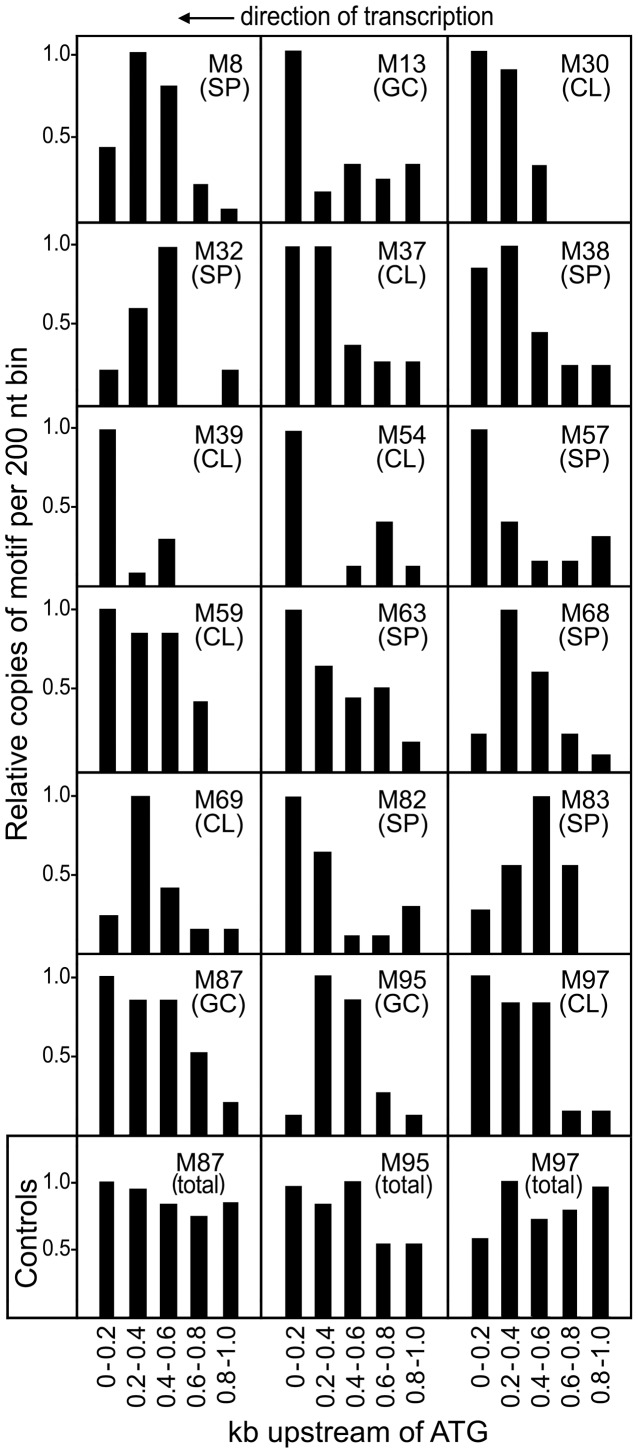
Positional bias of representative motifs within promoter space.The relative frequency of each motif is mapped across 200-nt bins taken from the relevant stage-induced promoter set, normalized to a value of 1.0 for the most populous bin. Marked in each panel is the motif and promoter dataset used for analysis, using the abbreviations in Figure 4. The bottom row shows three controls, indicating the frequency of three motifs in 2000 randomly selected promoters. The actual number of hits for each motif in the stage-induced promoter sets are in Table S1.